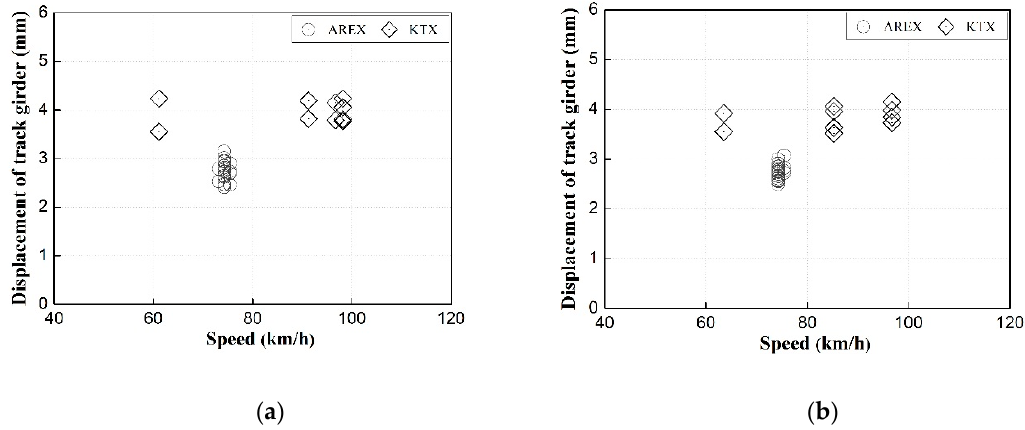
Figure 9. Measured displacement of the track girder by train type. ( a ) Before rail pad replacement and ( b ) after rail pad replacement.